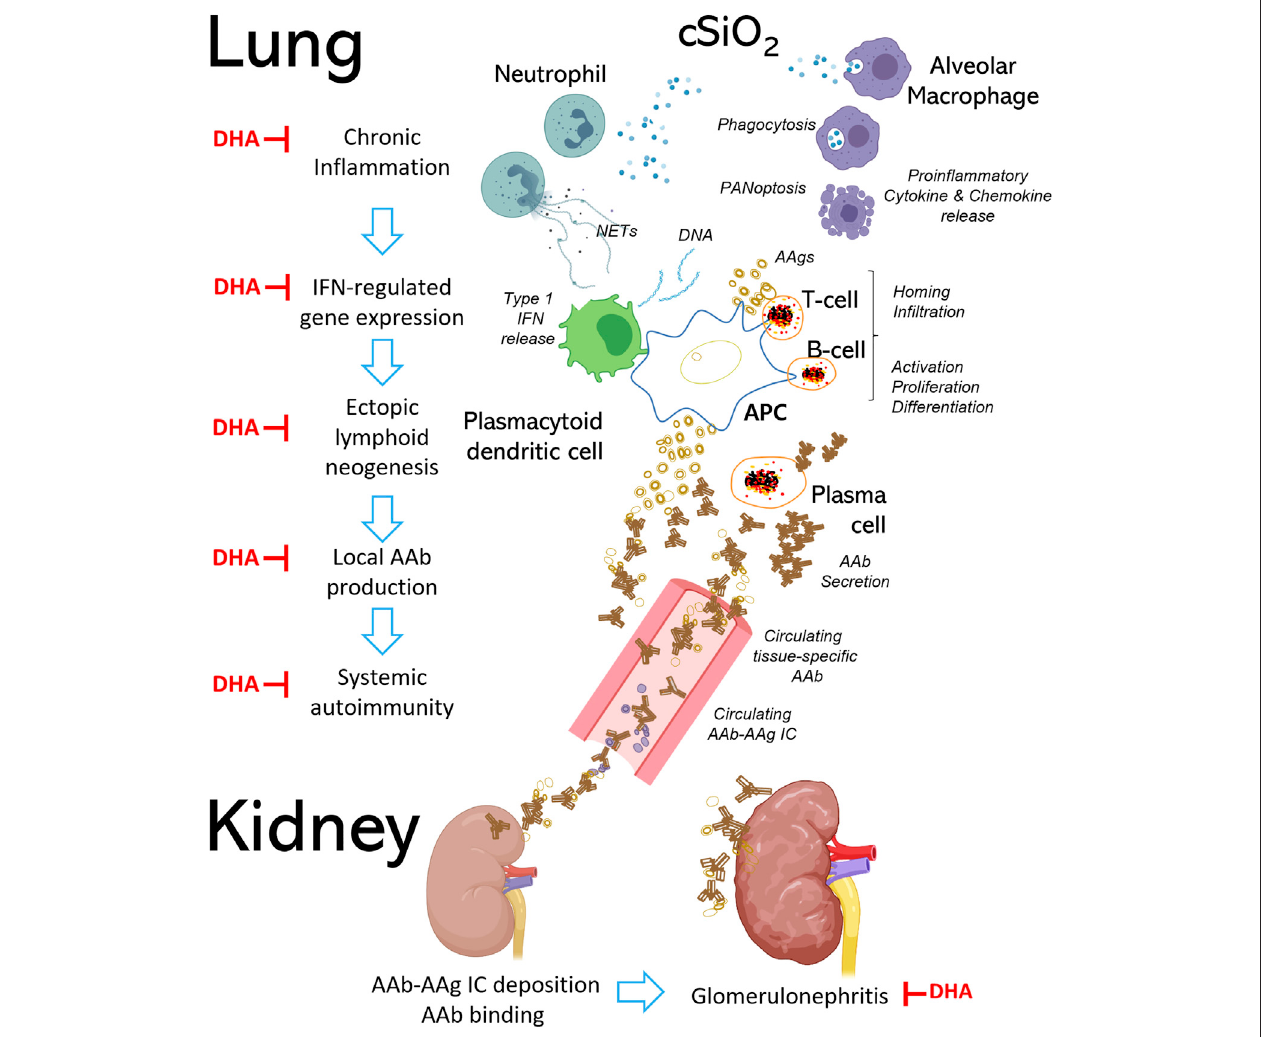
FIGURE 7 | Respirable cSiO 2 triggers autoimmune fl aring and progression in the SLE-prone female NZBWF1 mouse. Chronic exposure to respirable cSiO 2 particles contributes to irresolvable lung in fl ammation and systemic autoimmunity, resulting in end-stage glomerulonephritis and shortened lifespan in female NZBWF1 mice.Alveolarmacrophages(AM Φ s),whichserveasoneofthe fi rstlinesofimmunologicaldefenseinthelung,detectandphagocytoseinhaledcSiO 2 .Resultantly,cSiO 2 particles engulfed by AM Φ s induce immunogenic cell death (i.e., pyroptosis, apoptosis, necrosis), proin fl ammatory cytokine and chemokine release, and NETosis in neighboring neutrophils. Aberrant accumulation of dead cell corpses, proin fl ammatory mediators, and host nucleic acids promotes recruitment of autoreactive T and B cells into the lung and type I interferon (IFN) release from plasmacytoid dendritic cells, leading to formation of ectopic lymphoid tissue (ELT). Type I IFN triggers maturationofBcellsintoplasmacells,whichsecreteIgGautoantibodies(AAb)thattargetlocalandsystemicautoantigens(AAg).BindingofAAbstotheircorresponding AAgscanleadtoformationofimmunecomplexes (ICs)thatcirculate inthebodyviabloodvesselsand depositinother organssuch asthekidneys. Oncedeposited, ICs recruit additional proin fl ammatory cells to the tissue, ultimately resulting in irreversible kidney damage and failure. Steps at which DHA has been shown to interfere with these pathways are indicated by red ┴ symbols.